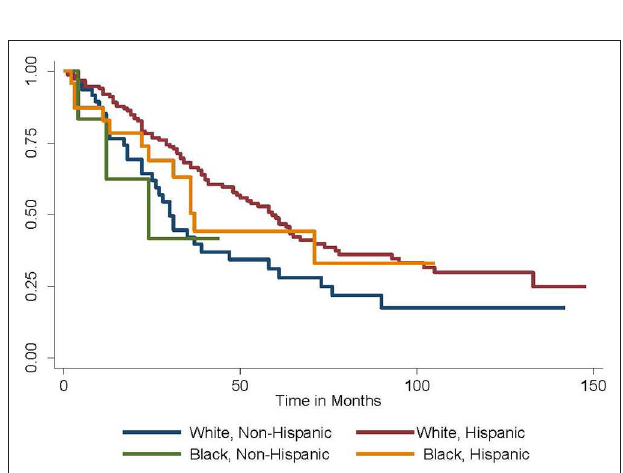
FIGURE 2 | Overall survival by race and ethnicity among Caribbean women with ovarian cancer. Hispanic ethnicity is protective, while Black race is associated with worse survival (log-rank p =